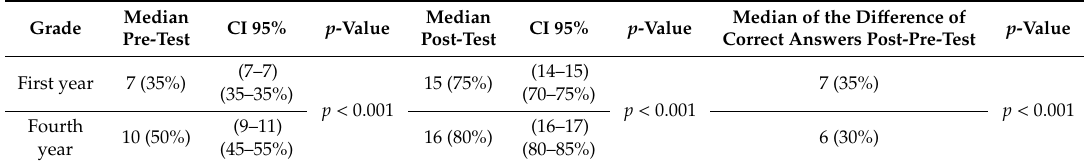
Table 2. Comparison of the distribution of correct answers between students from the first and fourth year, in the pre-test and post-test and the difference in performance between both tests (Mann– Whitney test).